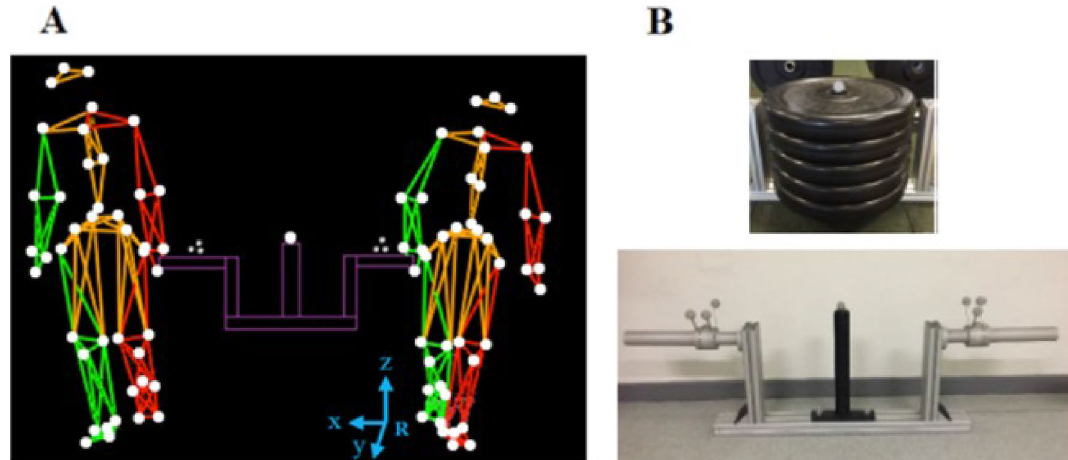
Figure 1. Collective load transport task and carried object. The pairs of volunteers ( A ) had to walk a distance of 20 m along a straight line while collectively carrying an object. Depending on experimental condition, the mass of the object they carried represented 20%, 30% or 40% of the sum of the body mass of the two volunteers. The white dots on the image correspond to kinematic markers. The kinematic model as reconstructed by the Vicon Nexus™ software is represented in red for the left side, in green for the right side, in orange for the head, trunk and pelvis, and in purple for the load. The global coordinate system (R) is indicated in the lower part of the figure, with x as medio-lateral axis, y as antero-posterior axis, and z as vertical axis. The carried object ( B ) was of the following dimensions: 1.16 × 0.45 × 0.37 m, and was equipped with force sensors at the handles. It comprised a rod at its center around which standard cast iron discs could be slid to increase its weight.